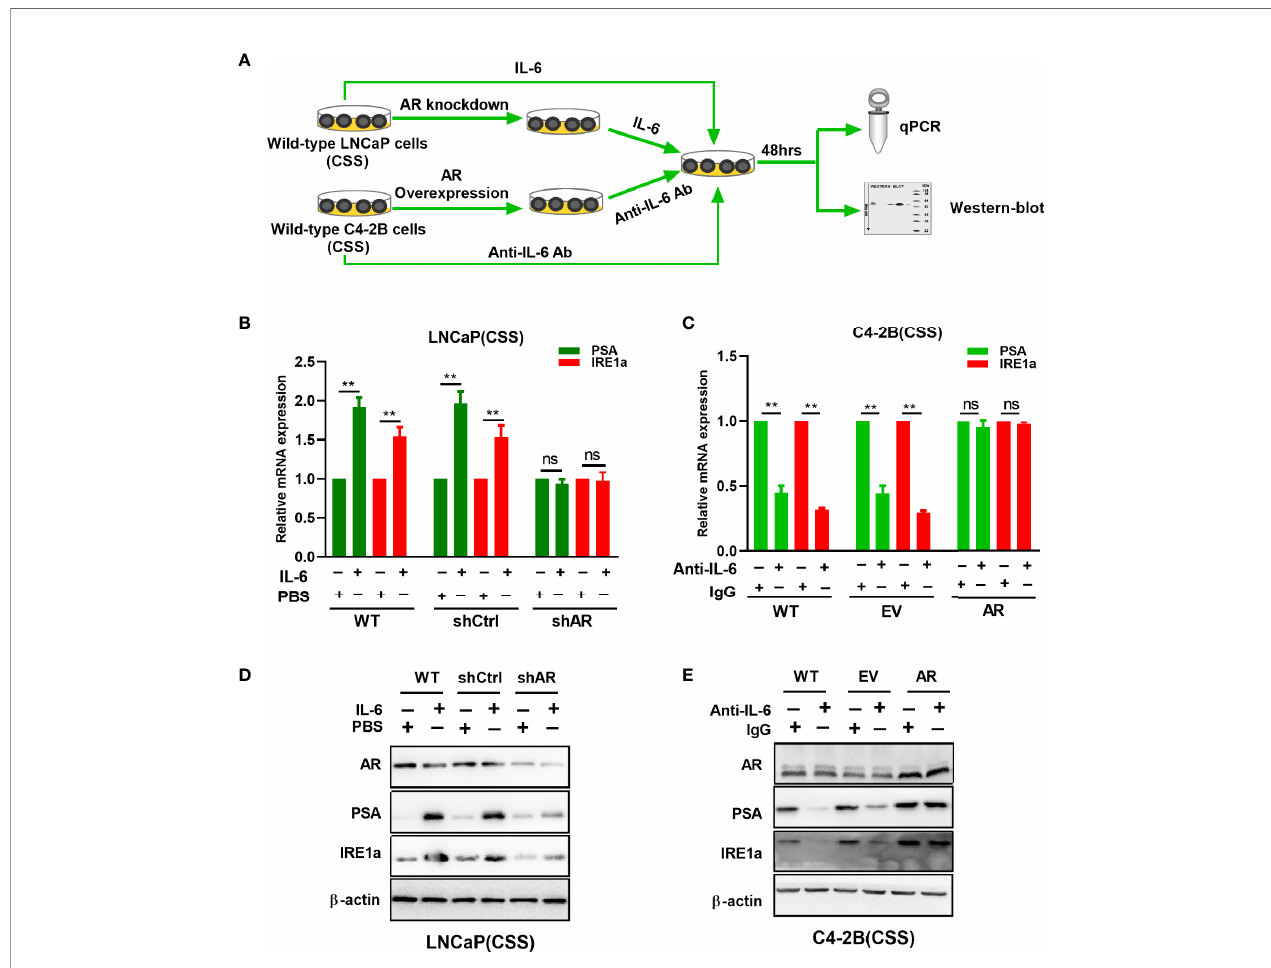
FIGURE 6 | The effect of IL-6 induced AR activation on IRE1 a expression. (A) Wild-type LNCaP cells or LNCaP cells with AR knockdown were treated with IL-6, and wild-type C2-4 cells or C2-4 cells with AR overexpression were treated with anti-IL-6 antibodies. The expression of AR target gene PSA and IRE1 a were analyzed by qPCR and western blot analysis. (B, D) qPCR and western blot analysis were used to analyzed for the expression of AR target gene PSA and IRE1 a in IL-6 treated wild-type LNCaP cells or LNCaP cells with AR knockdown. (C, E) qPCR and western blot analysis were used to analyzed for the expression of PSA and IRE1 a in anti-IL-6 antibodies treated wild-type C4-2B cells or C2-4 cells with AR overexpression. Data shown are the mean ± SD from three independent experiments, **P < 0.01; ns, no signi fi